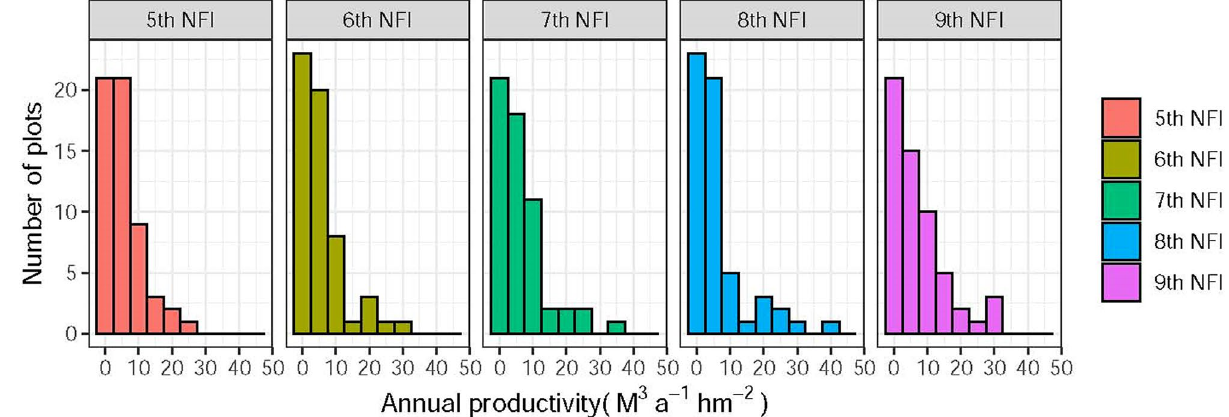
Figure 4. Distribution of mean annual productivity for sample plot from different